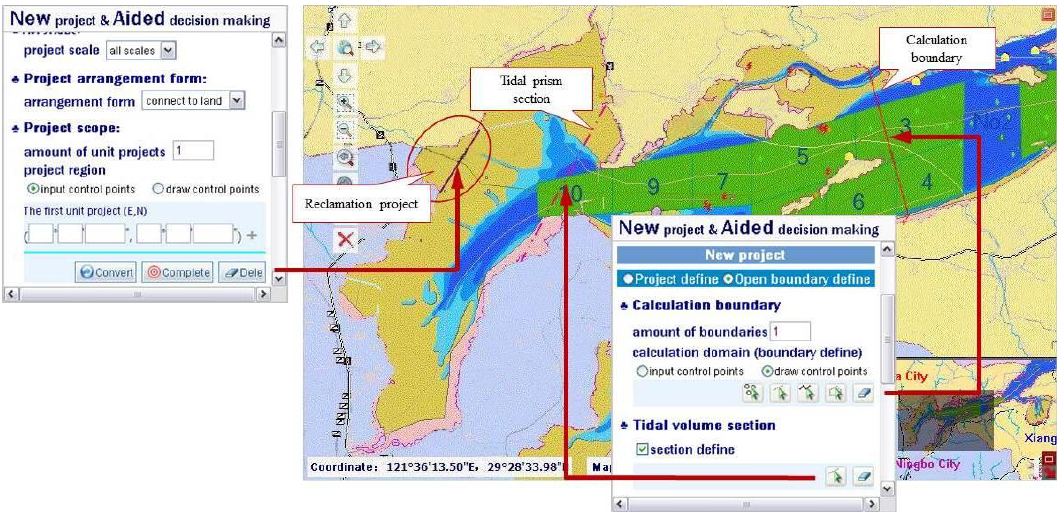
Figure 7. The new reclamation project defined on part of the webpage.